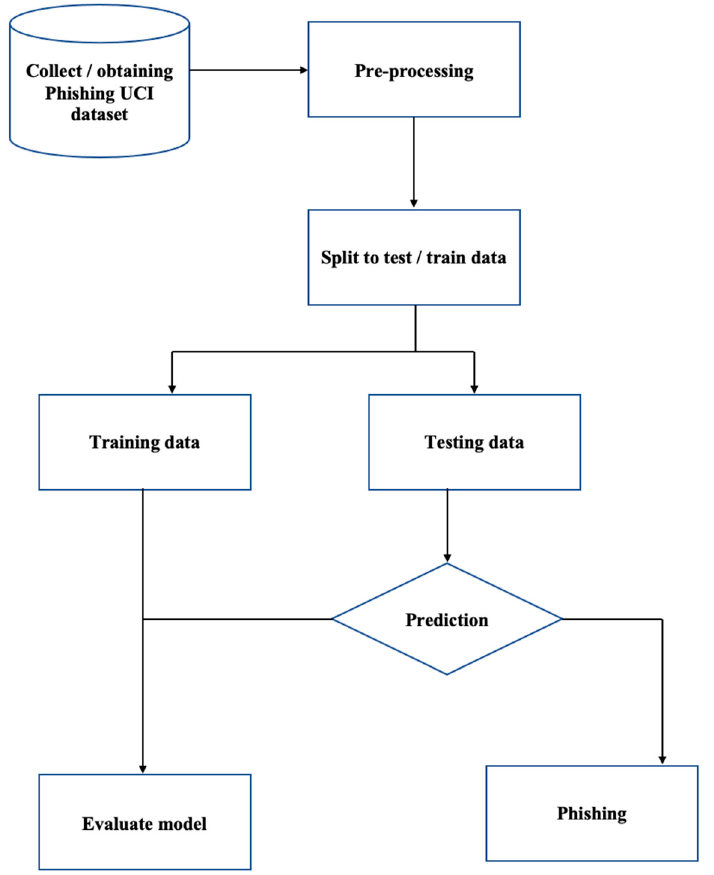
Figure 7. Model’s fl owchart.